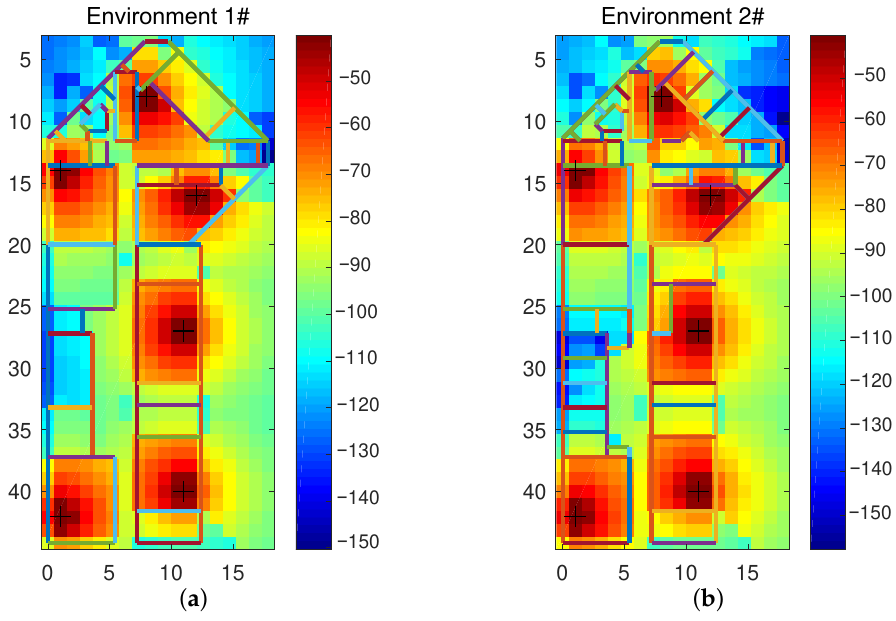
Figure 6. The layout (unit: meter) and the power heat maps (unit: dBm) of simulated indoor multi-wall model: ( a ) environment 1/the source domain; ( b ) Environment 2/the target